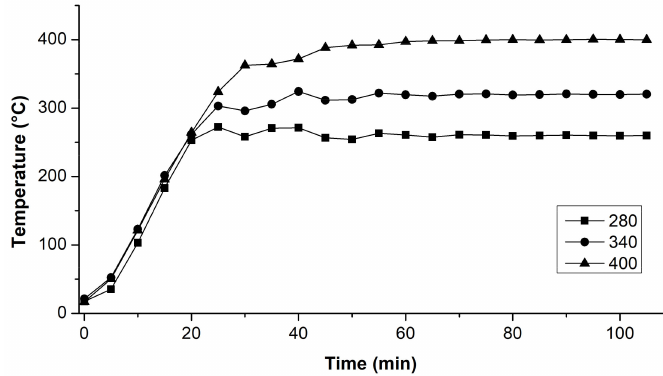
Figure 3. Temperature profiles for each pyrolysis temperature.